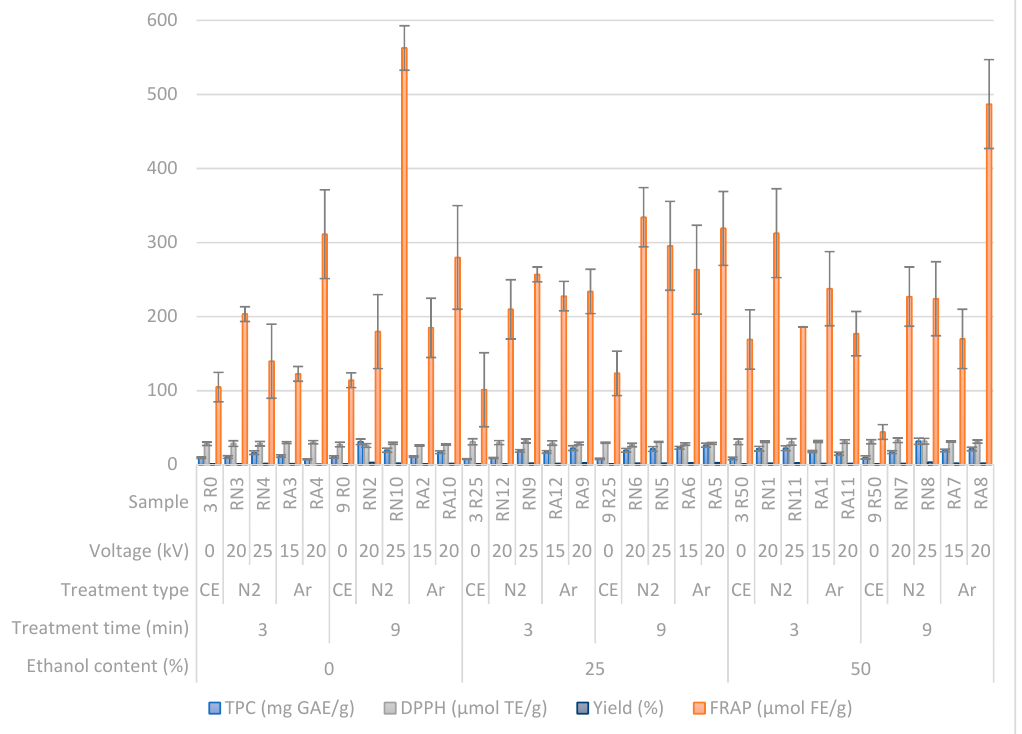
Figure 3. Determination of bioactive compounds—total phenolic compounds (TPC) values, antioxidant activity (2-diphenyl-2-picrylhydrazyl (DPPH) and ferric reducing ability of plasma (FRAP) and yield of extraction—measurements for CE and HVED treated samples. TPC = total phenolic content, DPPH = 2,2-diphenyl-2-picrylhydrazyl free radical assay, FRAP = ferric reducing ability of plasma; Treatment type: CE—conventional extraction, N 2 —HVED treatment with nitrogen, Ar—HVED treatment with argon.